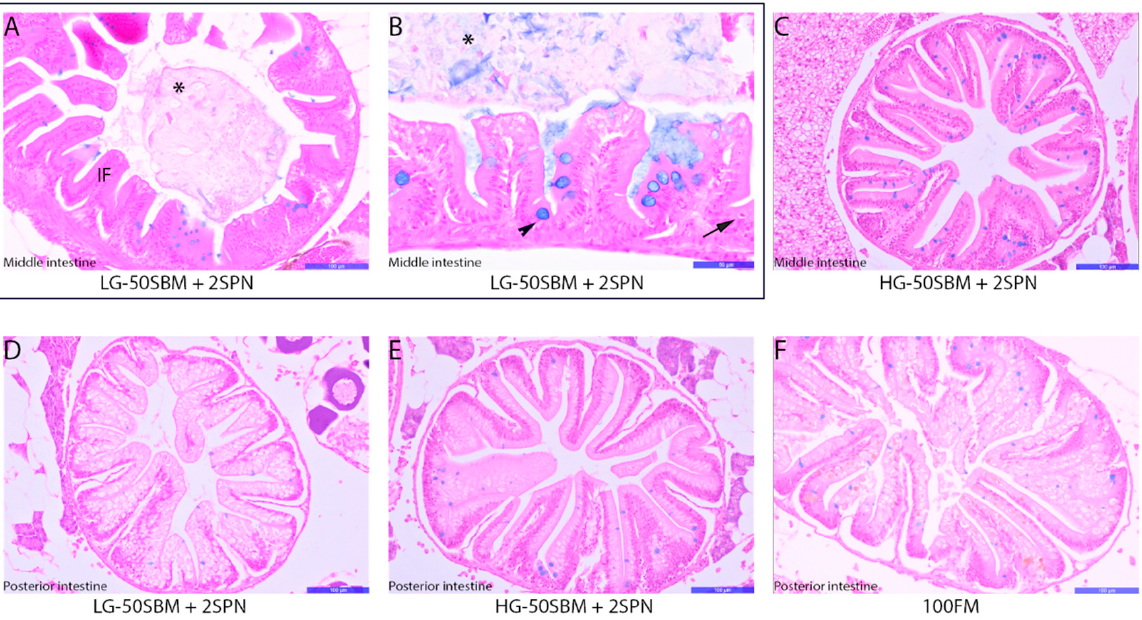
Figure 5. Optical microscopy of intestinal cross sections of zebrafish fed the experimental diets. Histological sections of the middle intestine of a LG-50SBM + 2SPN fish, presented inside the rectangle ( A , B ). Histological sections of the middle intestine of a HG-50SBM + 2SPN fish ( C ). Histological sections of the posterior intestine of LG- and HG-50SBM + 2SPN and 100FM fish ( E , F ). (IF) decreased intestinal fold size and enlarged intestinal lumen; (asterisk) mucus; (arrowhead) goblet cells; (arrow) intraepithelial leukocytes. The scale bar for ( A , C – F ) corresponds to 100 µ m, and the scale bar for ( B ) corresponds to 50 µ m.